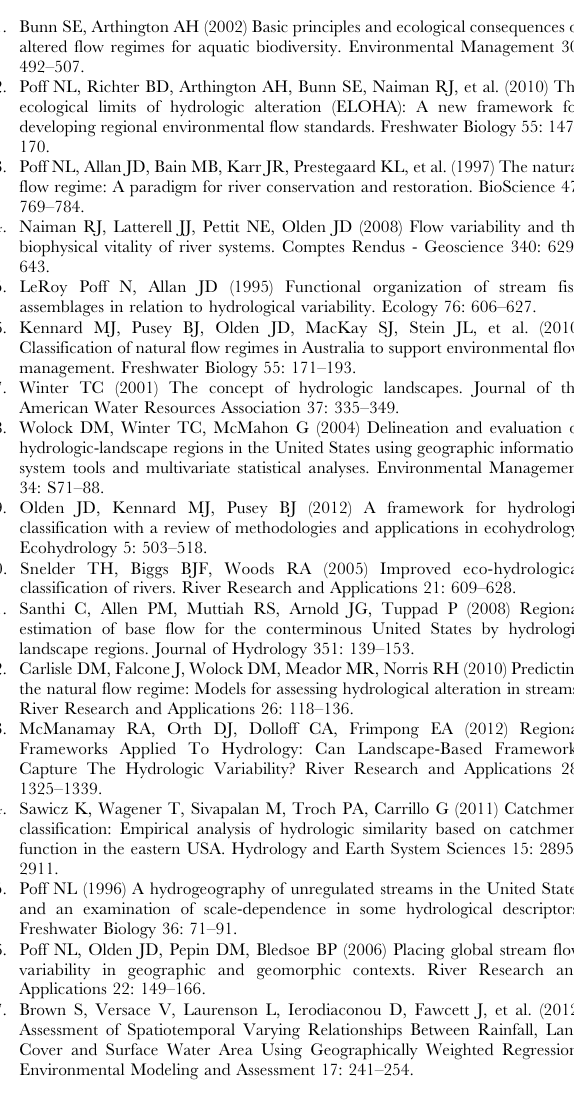
80% training data, while others were excluded by the bootstrap aggregation step used to train the RF models. tation test for testing for differences between the resampled and original classifications. umns. The first column is the point ID from the random subsample used for comparisons between the original and resampled classifications, the remaining columns are the ‘‘true’’ class from the ALOC clustering, the class extracted from the location of the 30-m RF classification, and the class extracted from the 2.5-km resampled RF